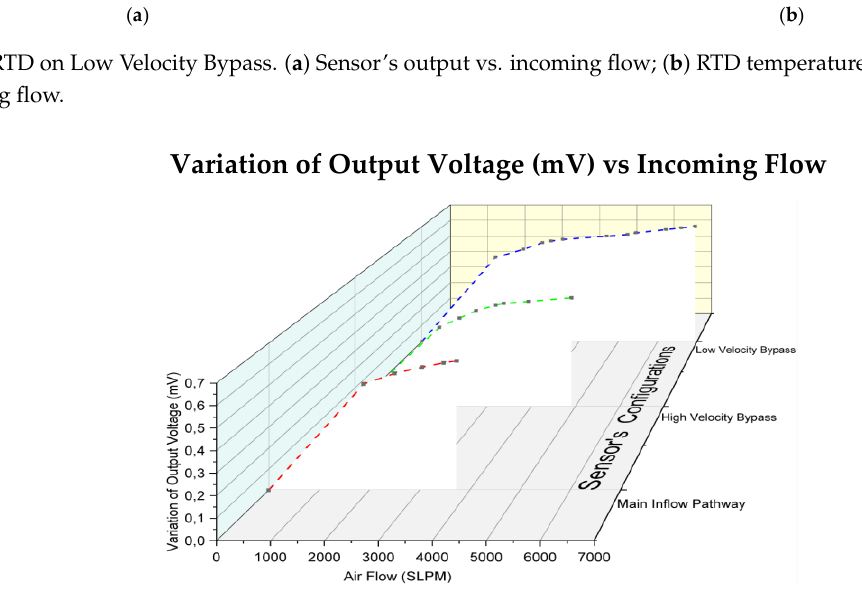
the three locations on which the sensing RTD element was mounted).